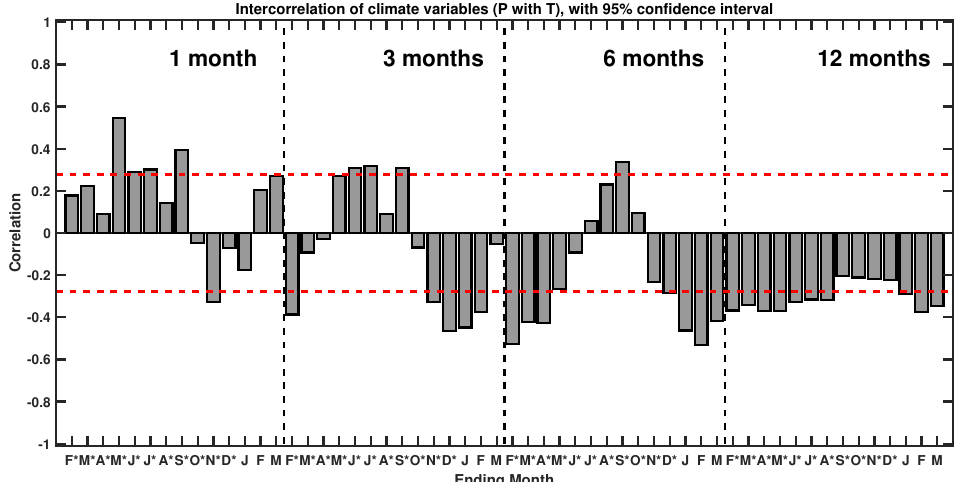
Figure 6. Intercorrelation of the climatic variable (precipitation and temperature) for 1, 3, 6, and 12 month-period moving